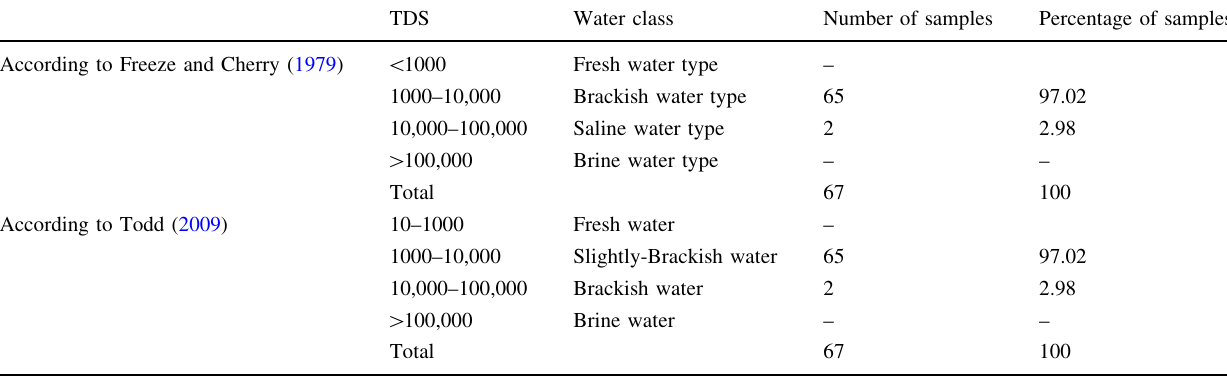
Table 4 Classification of groundwater according to the TDS